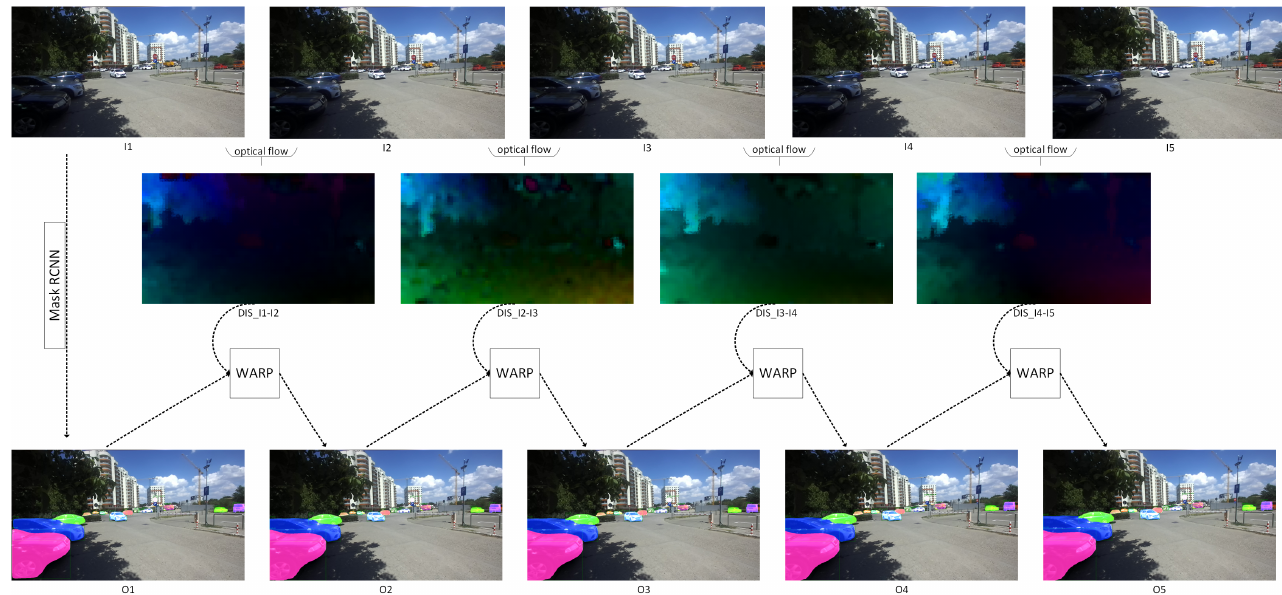
Figure A2. Framework results—our dataset (1): I x —input image x , DIS _ I x − I y —optical flow (DIS_ultrafast) between I x and I y , O x —output